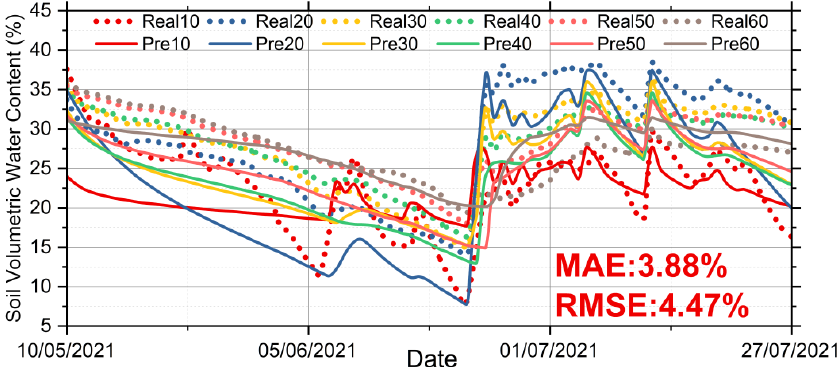
Figure 8. Simulation effect of parameters for the ISHD inverse solution method on JKT608.